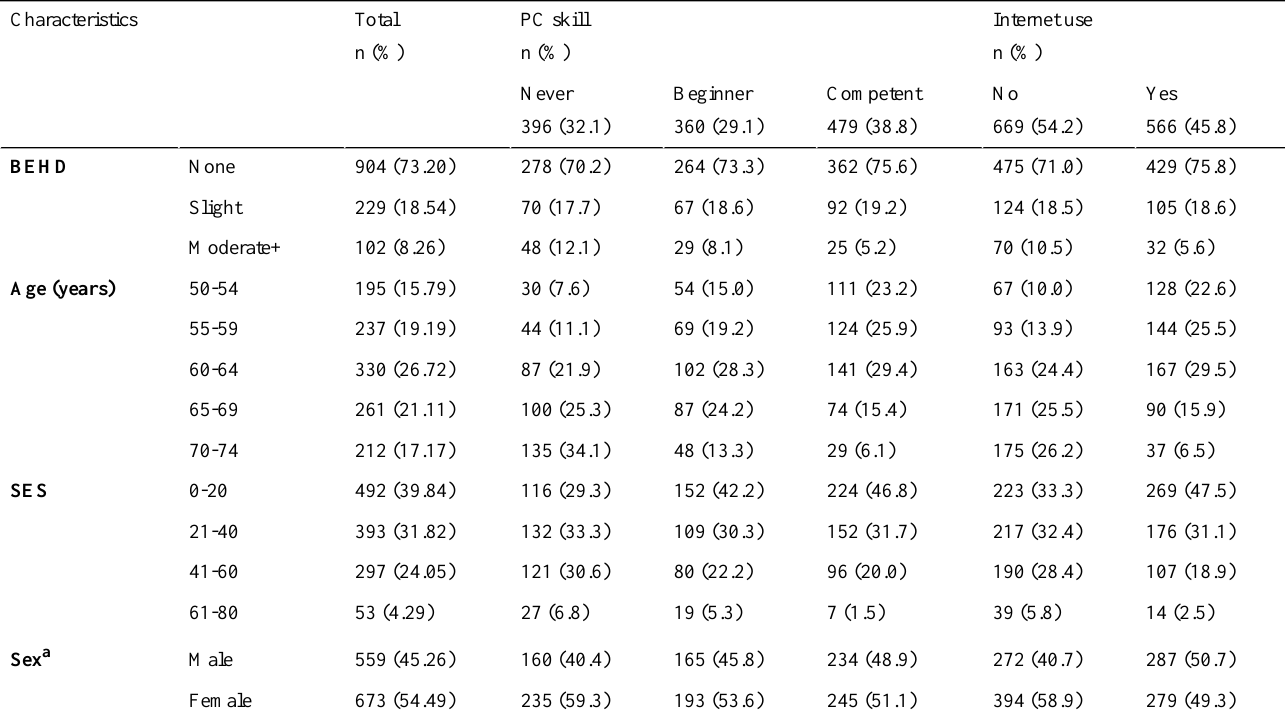
Table 2. Better-ear hearing difficulty (BEHD) and demographics of postal questionnaire respondents (n=1235) by PC skill and Internet use.